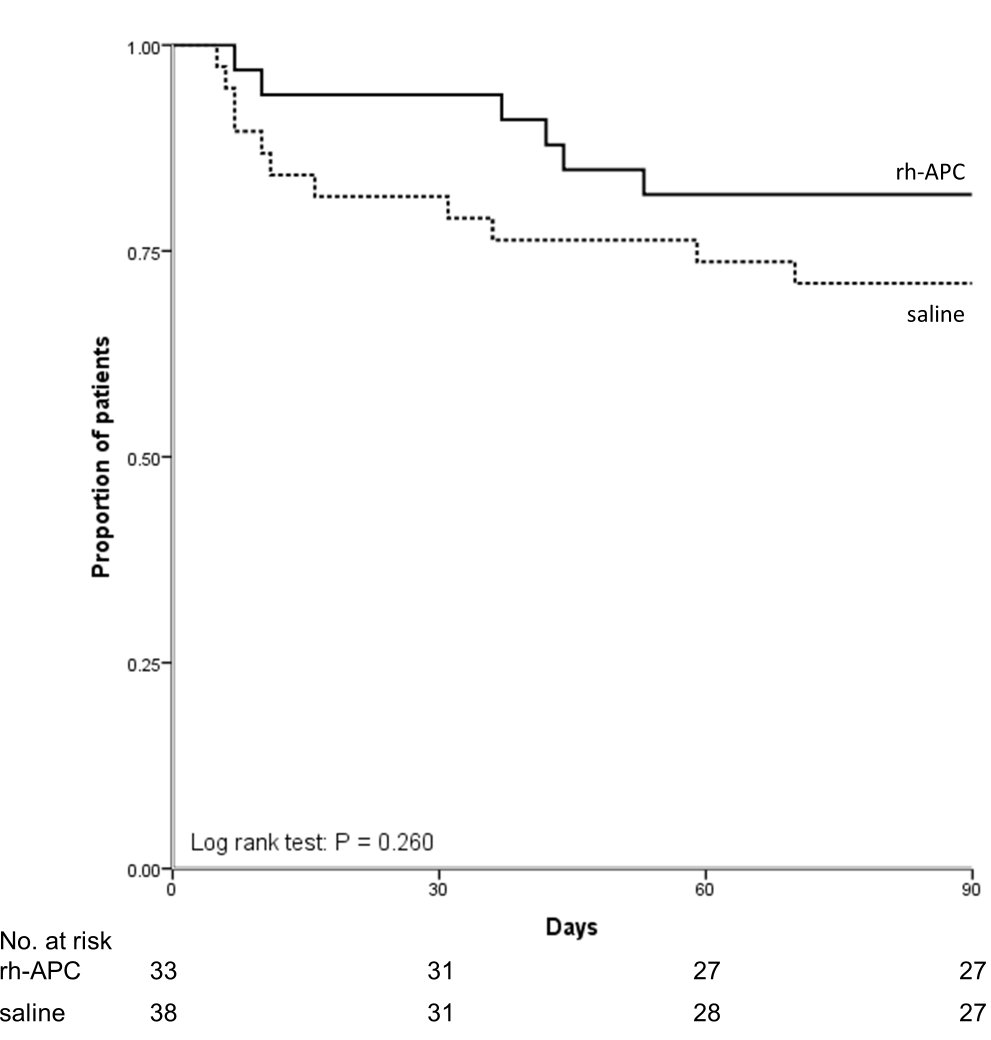
Figure 4. Probability of survival until day 90 in study groups.